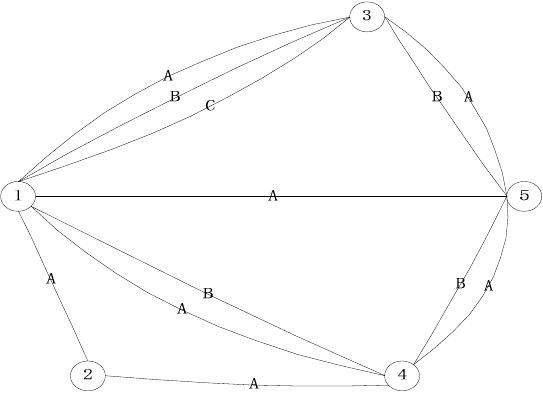
Figure 1. Schematic diagram of multi-path network.